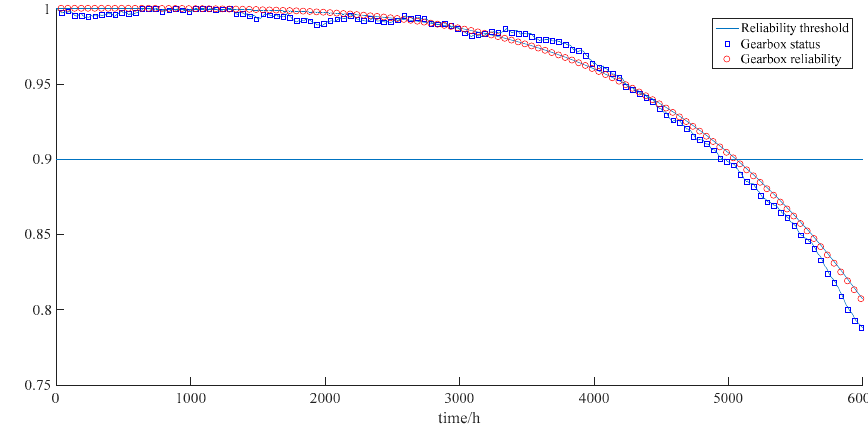
Figure 1. Gear box state and reliability transform diagram.